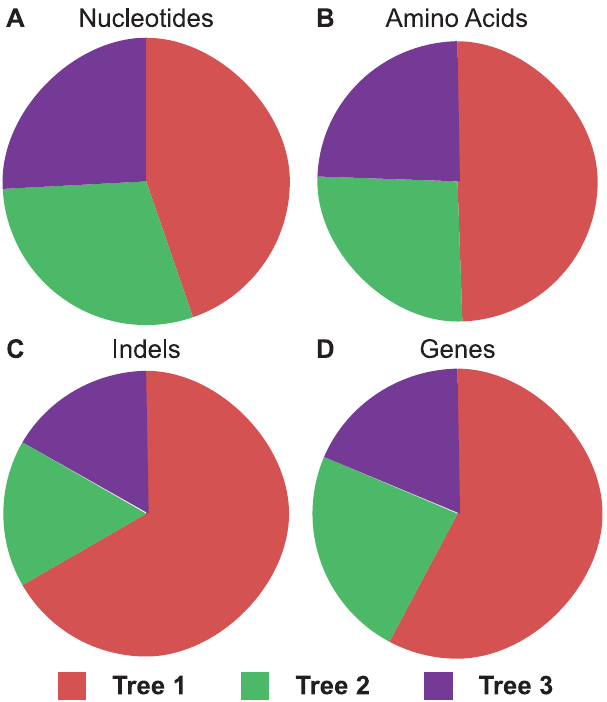
Figure 2. Widespread Incongruence of Substitutions, Indels, and Gene Trees (A) The proportion of informative nucleotide substitutions in 9,405 genes supporting each of the three trees. Tree 1 (red) is supported by 170,002 (44.7%) nucleotide changes; tree 2 (green), 112,278 (29.5%) nucleotide changes; and tree 3 (purple), 98,117 (25.8%) nucleotide changes. (B) The proportion of informative amino acid substitutions in 9,405 genes supporting each of the three trees. Tree 1 (red) is supported by 28,628 (49.3%) amino acid changes; tree 2 (green), 15,182 (26.2%) amino acid changes; and tree 3 (purple), 14,203 (24.5%) amino acid changes. (C) The proportion of informative insertions or deletions (indels) in 9,405 genes supporting each of the three genes. Indels were filtered, requiring five flanking amino acids of perfect identity and no repetitive sequence. Tree 1 (red) is supported by 2 deletions and 6 insertions (66.7%); tree 2 (green), 1 deletion and 1 insertion (16.7%); and tree 3 (purple), 2 insertions (16.7%). Similar proportions but much larger counts are found when the indels are not filtered. (D) The proportion of 9,315 genes with ML support for each of the three trees. Tree 1 (red) has ML support for 5,381 (57.8%); tree 2 (green), 2,188 (23.5%); and tree 3 (purple), 1,746 (18.7%). DOI: 10.1371/journal.pgen.0020173.g002